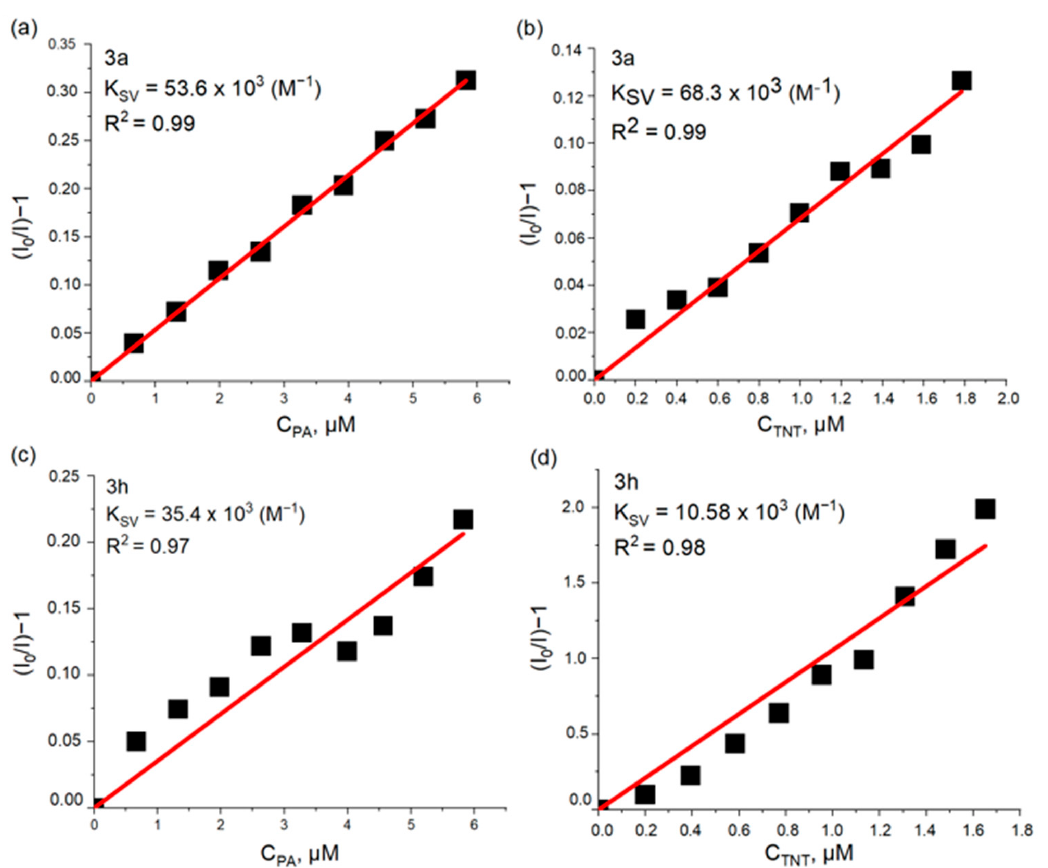
Figure 9. Stern–Volmer plots for the fluorescence quenching of 3a in the presence of PA ( a ) and TNT ( b ), 3h in the presence of PA ( c ) and TNT ( d ) in a media of THF. Concentrations of 3a and 3h are 10 µ M, PA and TNT—200 µ M. Obtained by the single point method.